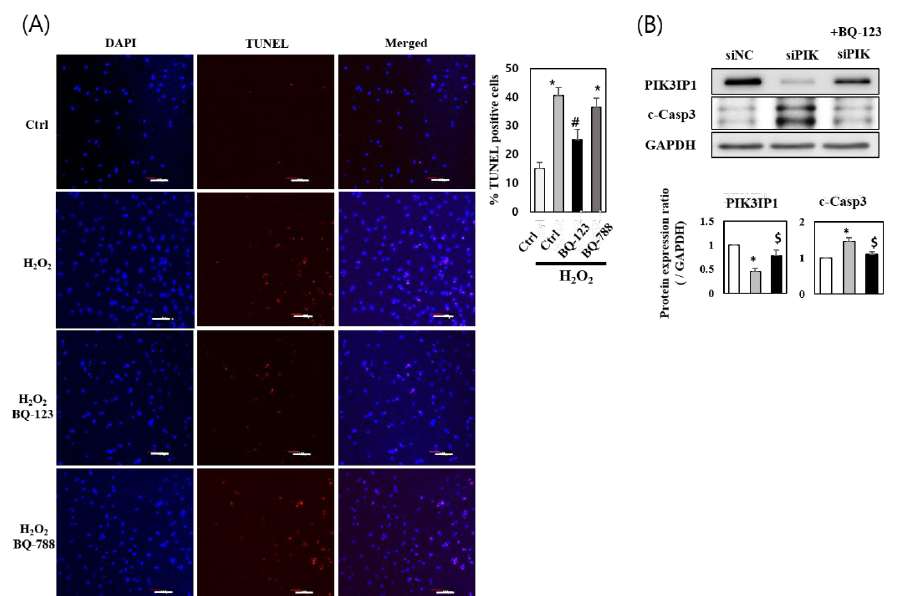
Figure 5. H 2 O 2 induced cardiomyocyte cell death via activation of ET A -PIK3IP1 binding: ( A ) H9c2 cells were treated with H 2 O 2 (200 μM) for 24 h after pretreatment with BQ-123 (10 μ M) or BQ-788 (10 μ M) or DMSO. Fragmentation was detected via TUNEL assay and cells were counterstained with DAPI for nuclei staining. The scale bar represents 200 μm. ( B ) H9c2 cells were transfected with siPIK (si-PIK3IP1) or siNC (negative control) for 24 h (25 nM each), and subsequently treated with or without BQ-123 (10 μ M) for 3 h. The protein expression levels were measured via Western blotting. Results are presented as mean ± SEM; n = 3 – 5; statistical significance is shown as * p < 0.05 relative to control group (Ctrl or siNC). # p < 0.05 relative to H 2 O 2- treated group. $ p < 0.05 relative to siPIK group.